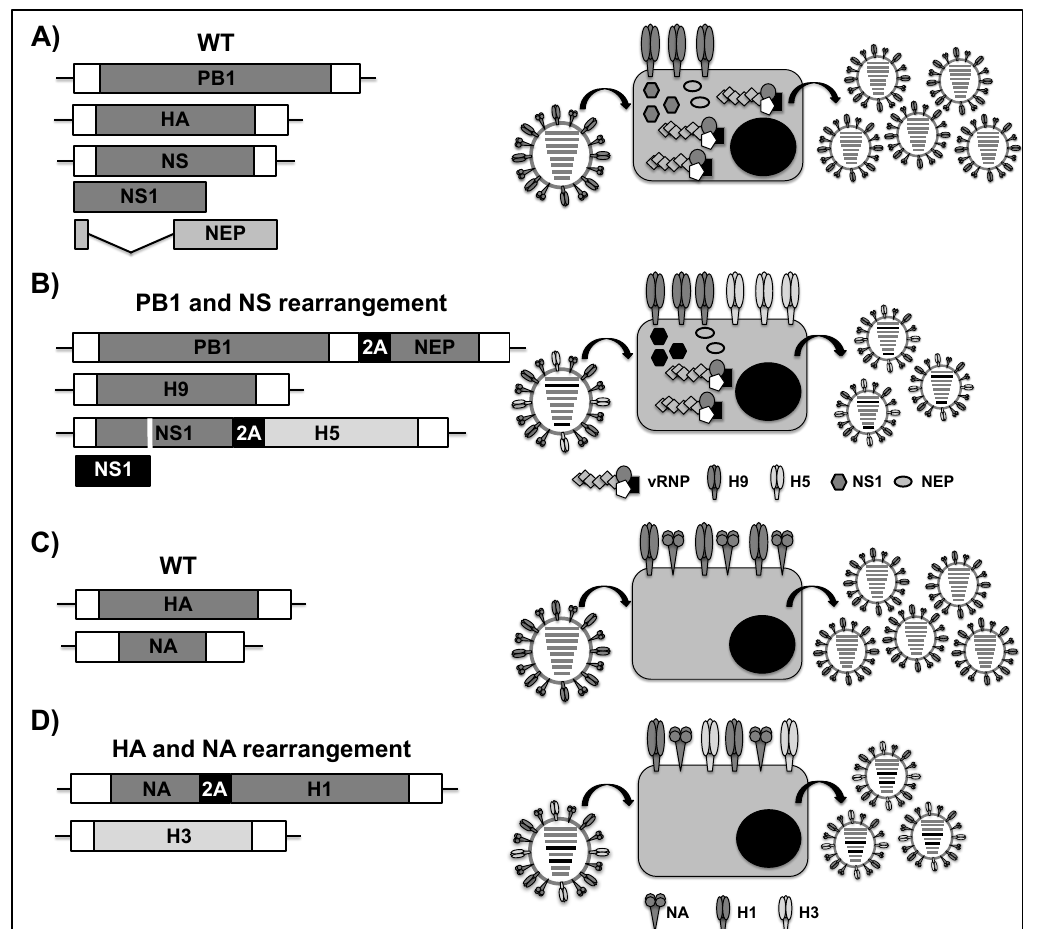
Figure 7. Rearrangement of IAV genome for the generation of LAIV: ( A , B ) Schematic representation of WT (A) and rearranged viral segments 2 (PB1) and 8 (NS) (B): WT segments 2, 4, and 8 (A) or rearranged segment 2 (PB1 and NEP) and segment 8 (NS1) are indicated with dark gray boxes (B) The light gray box indicates the secondary H5 inserted in the NS segment. White boxes (A and B) indicate the packaging signals located at the 3´and 5´ ends of each vRNA. Black boxes (B) indicate the sequence of the foot-and-mouth disease virus (FMDV) 2A autoproteolytic cleavage site. Lines at the end of each vRNA (A and B) indicate the 3´and 5´ NCR. A white line in the NS segment (B) represents a stop codon in the NS1 resulting in a truncated (1-99 amino acids) NS1 protein (black box). Expression of NEP from a single polypeptide downstream of the modified PB1 viral segment results in a reduction on the activity of the PB1and an impaired growth of the rearranged virus (B). The expression of the H5 ORF from a modified segment 8 results in an LAIV expressing two different HA (H9, dark gray; and H5, light gray) and the induction of neutralizing antibodies against the two viral glycoproteins. ( C , D ) Schematic representation of WT (C) and rearranged segment 4 (HA) and segment 6 (NA) viruses (D): WT (C) and rearranged segment 4 expressing NA-HA (D) are represented in dark gray boxes. Rearranged segment 6 expressing a secondary HA is represented in a light gray box (D). White boxes indicate the packaging signals located at the 3´and 5´ ends of each vRNA (C and D). Black boxes indicate the sequence of the porcine teschovirus (PTV-1)2A autoproteolytic cleavage site (D). Lines at the end of each vRNA indicate the 3´and 5´ NCRs (C and D). While WT virus expresses the HA and NA glycoproteins from the segment 4 and 6 respectively (C), the rearranged virus expresses both the subtype 1 HA and NA glycoproteins from the modified segment 4; and the subtype 3 HA from the modified segment 6, where NA is normally located (D). This rearrangement of the viral genome results in an attenuated recombinant virus able to induce neutralizing antibodies against the two viral glycoproteins (H1 and H3) (D).